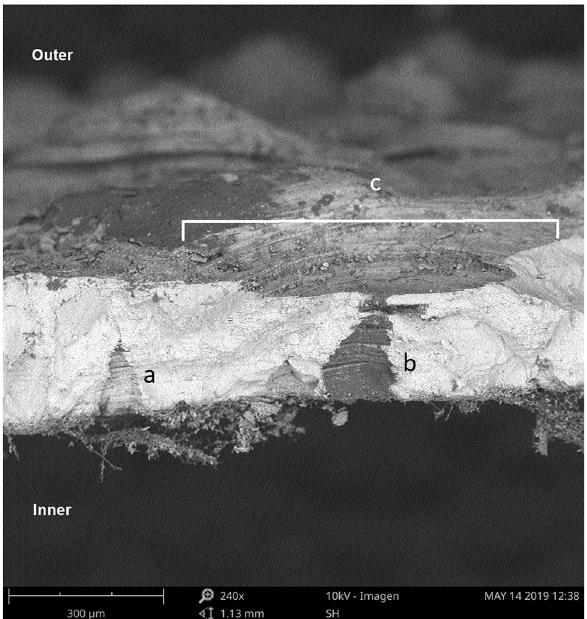
Figure 1. Radial view of an eggshell under SEM (Scanning Electron Microscope). We show (a) a pore-canal without external aperture, (b) pore-canal with external aperture and the air chamber in upper position, and (c) a crater above the pore